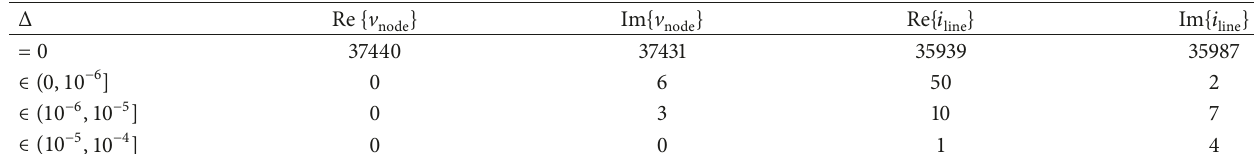
Table 2: Number and magnitude of absolute deviations Δ among node voltages and line currents (unit of Δ is V for voltages and A for currents).